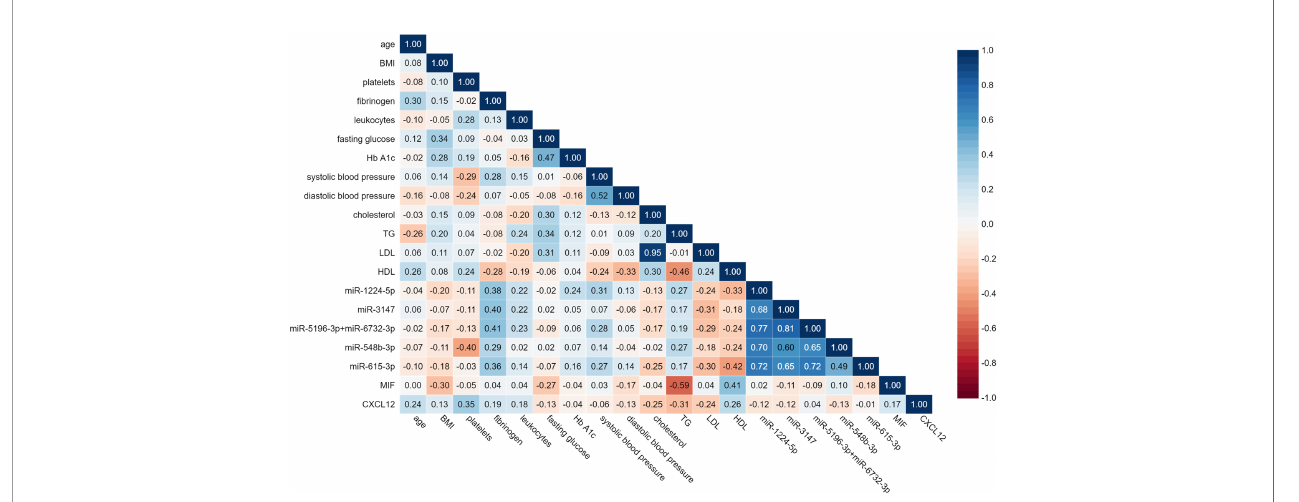
FIGURE 6 | Spearman ’ s rank-matrix correlation between tested miRNAs, MIF, CLXC12 and clinical parameters. The blue colour indicates a positive correlation, and red indicates the